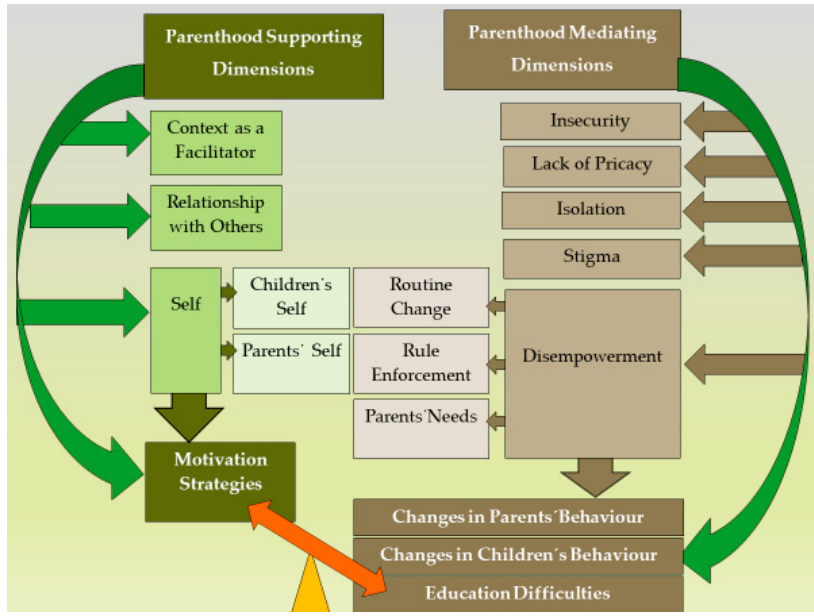
Figure 2. Overview of the synthesised findings.